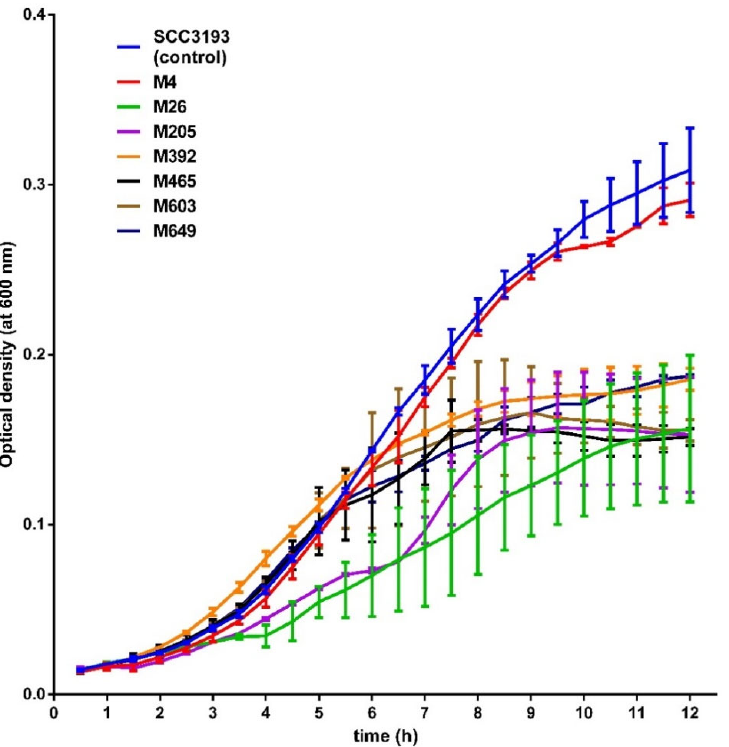
Figure 5. Growth of wild-type P. parmentieri SCC 3193 and phage-resistant mutants at pH 5.0. The experiment was performed in two biological replicates each containing two technical replications ( n = 4). The results were averaged for presentation, the bars show standard deviation (SD).